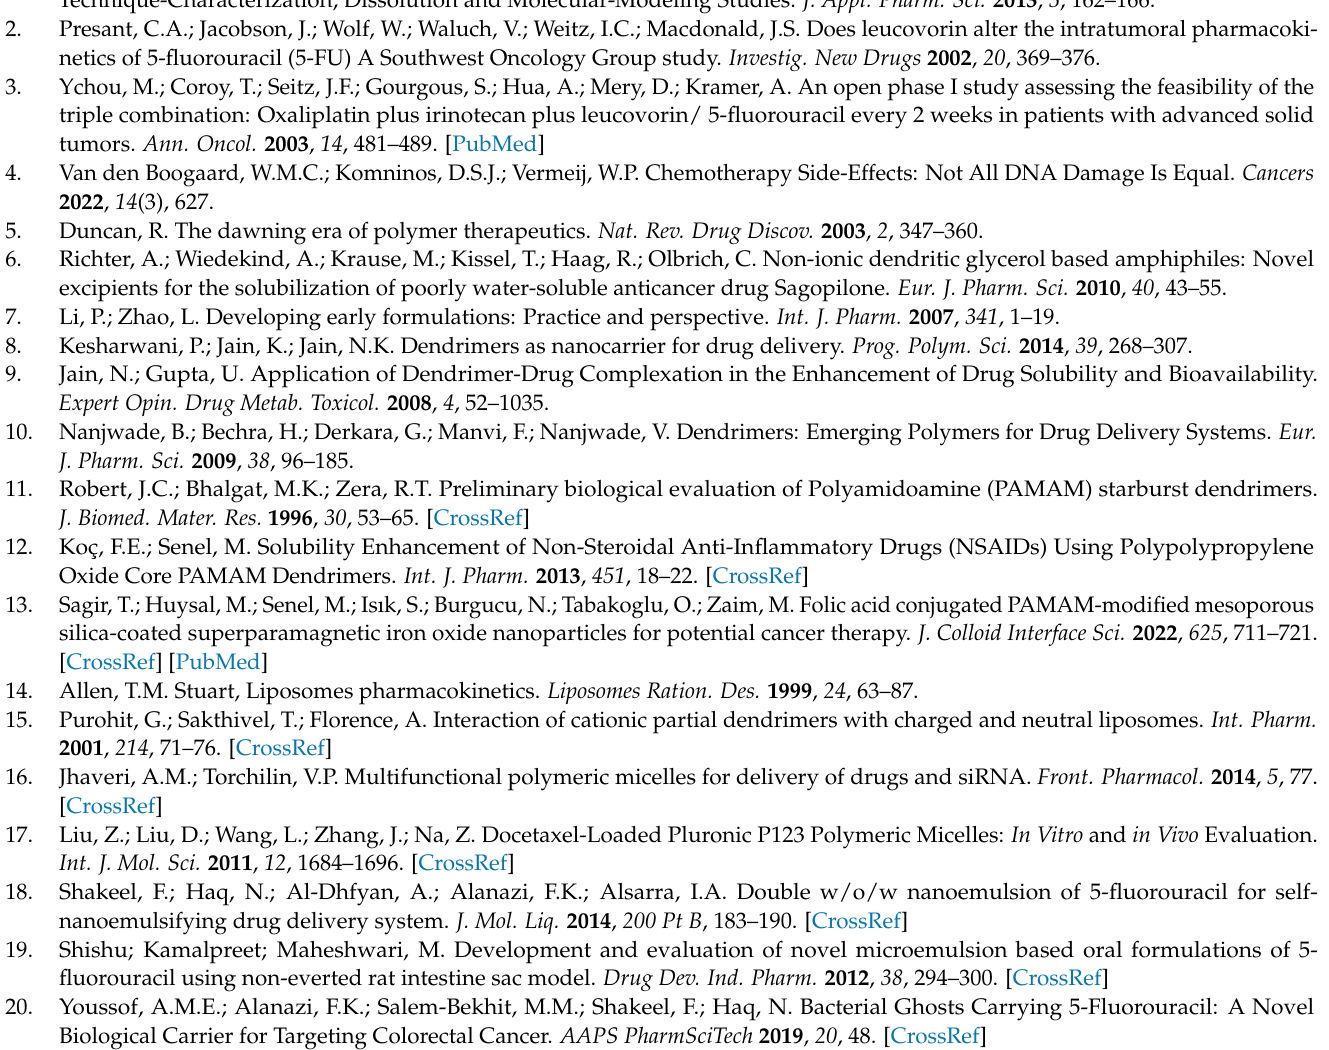
0.5; Figure S3. FT-IR analysis of DL-G0; Figure S4. FT-IR analysis of DL-G0.5; Figure S5. FT-IR analysis of DL-G1; Figure S6. FT-IR analysis of DL-G1.5; Figure S7. FT-IR analysis of DL-G2; Figure S8. FT-IR analysis of DL-G2.5; Figure S9 FT-IR analysis of DL-G3; Figure S10: 1H NMR analysis of A) DL-G1 B) DL-G2 C) DL-G3; Figure S11: 13 C NMR analysis of A) DL-G1 B) DL-G2 C) DL-G3; Table S1: CMC and particle characteristics of micellar